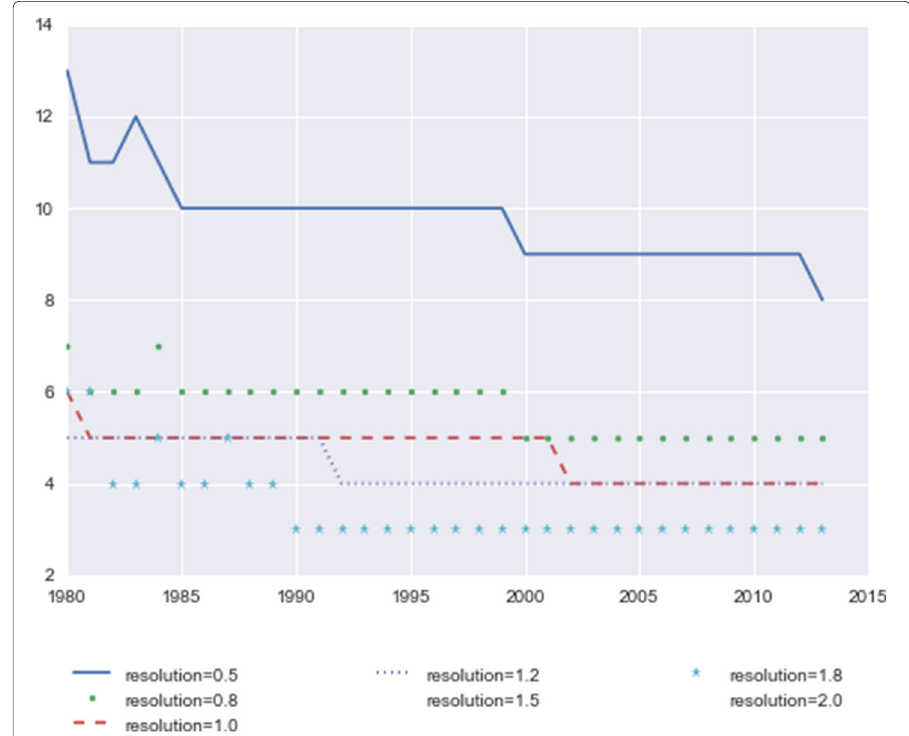
Fig. 1 Number of communities at different resolutions. The x-axis indicates years from 1980 to 2013, and the y-axis indicates number of